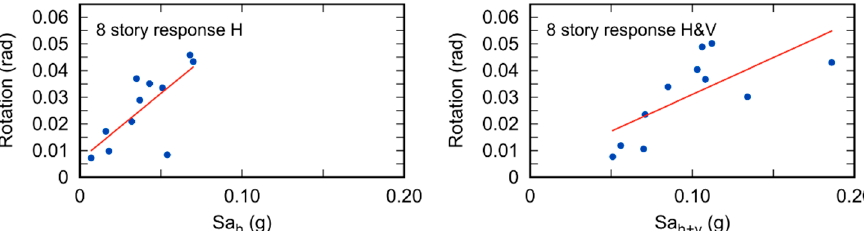
Figure 27. Rotation as a function of Sa for the 8-story building beam (see Figure 19). Left for the horizontal component, right for the horizontal plus vertical component.